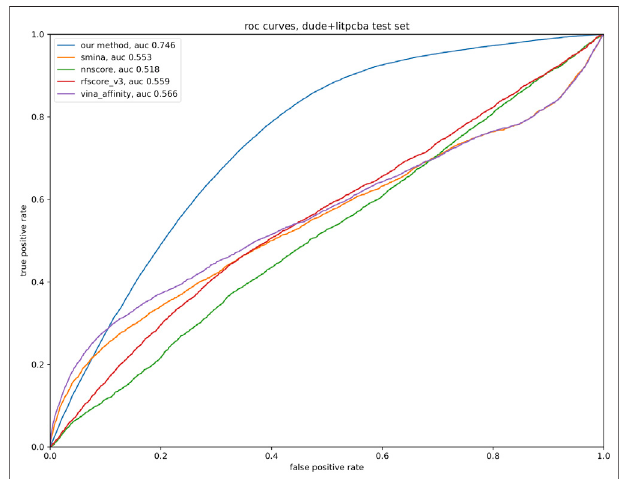
FIGURE 3 | Test data consisting of 3,900 ligand-protein pairs and 213,000 decoy-protein pairs was analyzed with the tools listed in the legend, withtherelevanttoolproducingabindingaf fi nityestimateforeachpair.Default parameters were used for all tools; our model was trained as described in the text. A ROC curve was produced for each tool, based on the sorted list of predicted af fi nity.